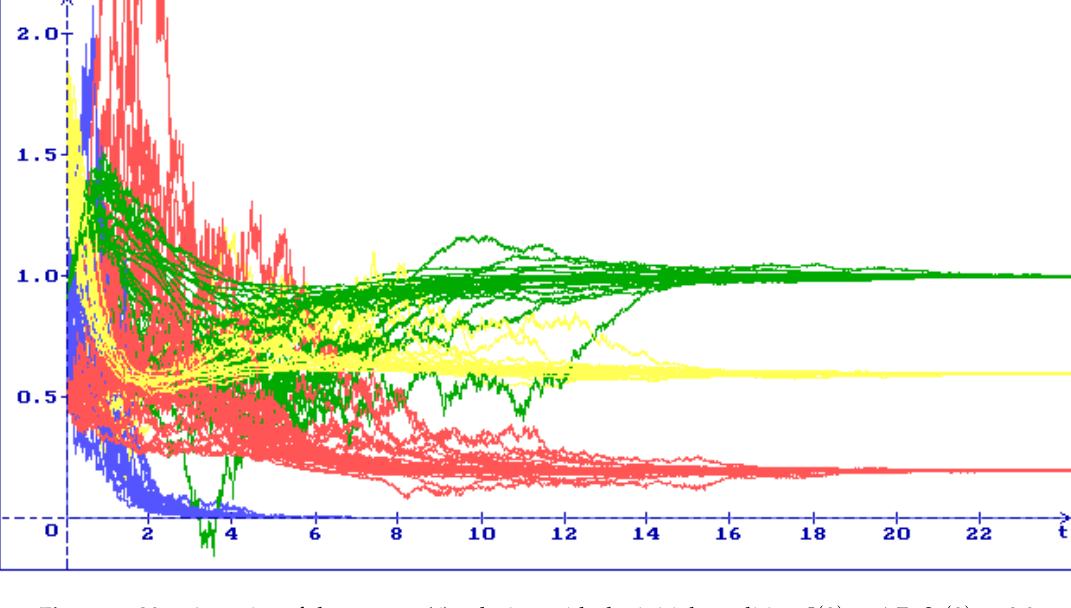
Figure 3. 30 trajectories of the system (6) solution with the initial condition I ( 0 ) = 1.7, S 1 ( 0 ) = 0.9, S 2 ( 0 ) = 0.7, R ( 0 ) = 0.5: all trajectories I ( t ) (yellow), S 1 ( t ) (green), S 2 ( t ) (blue), R ( t ) (red) converge